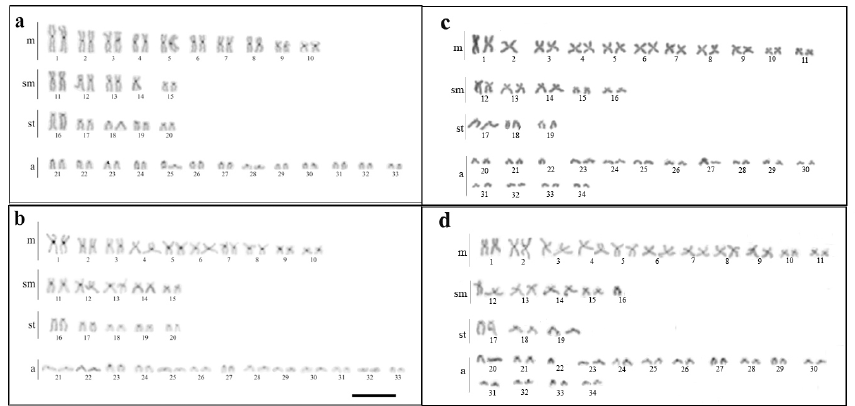
Figure 2 – (a) Metaphase of P. motoro showing the 5S rDNA (red) and 18S (green) fluorescent signals; (b) Metaphase of Potamotrygon sp. showing the rDNA 5S (green) and 18S (red) fluorescent signals.